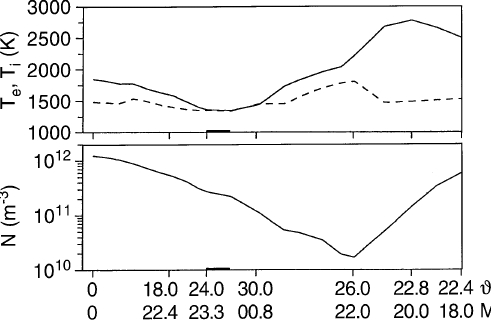
Fig. 2. The variations along the part of the convection trajectory, presented in Fig. 1, ( top ) of „ (cid:37) ( solid line ) and „ (cid:42) ( dashed line ) in absolute degrees, and ( bottom ) of N in m (cid:126)(cid:51) at level h " 300 km under natural conditons without HF heating. Coordinates (mag- netic colatitude (cid:48) and MLT) for some locations on the convection trajectory are pointed out near the